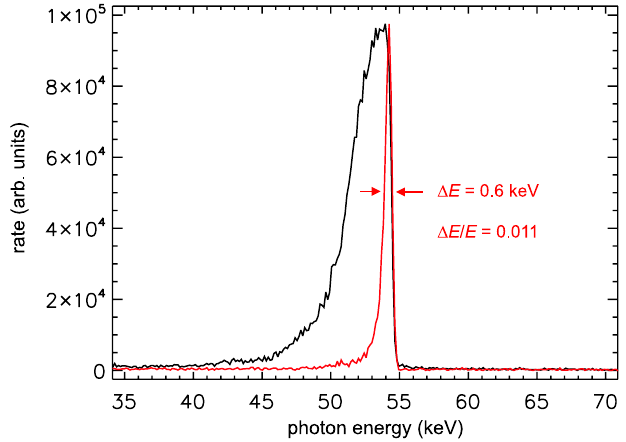
FIG. 7. (Color) Influence of the limitation of the angular accep- tance by a collimator on the spectrum of the backscattered photons. With collimation by a tungsten collimator ( r ¼ 4 mm at a distance of approximately 11.8 m from the middle of the interaction region), quasimonochromatic x rays can be produced (red curve). The black curve shows the spectrum measured without a collimator. The angular acceptance is then determined by the size of the x-ray detector ( r ¼ 12 : 6 mm , placed at a distance of approximately 12.0 m from the middle of the interaction region).